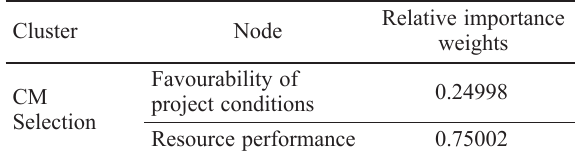
Table 6. Relative importance weights of clusters Cluster Node